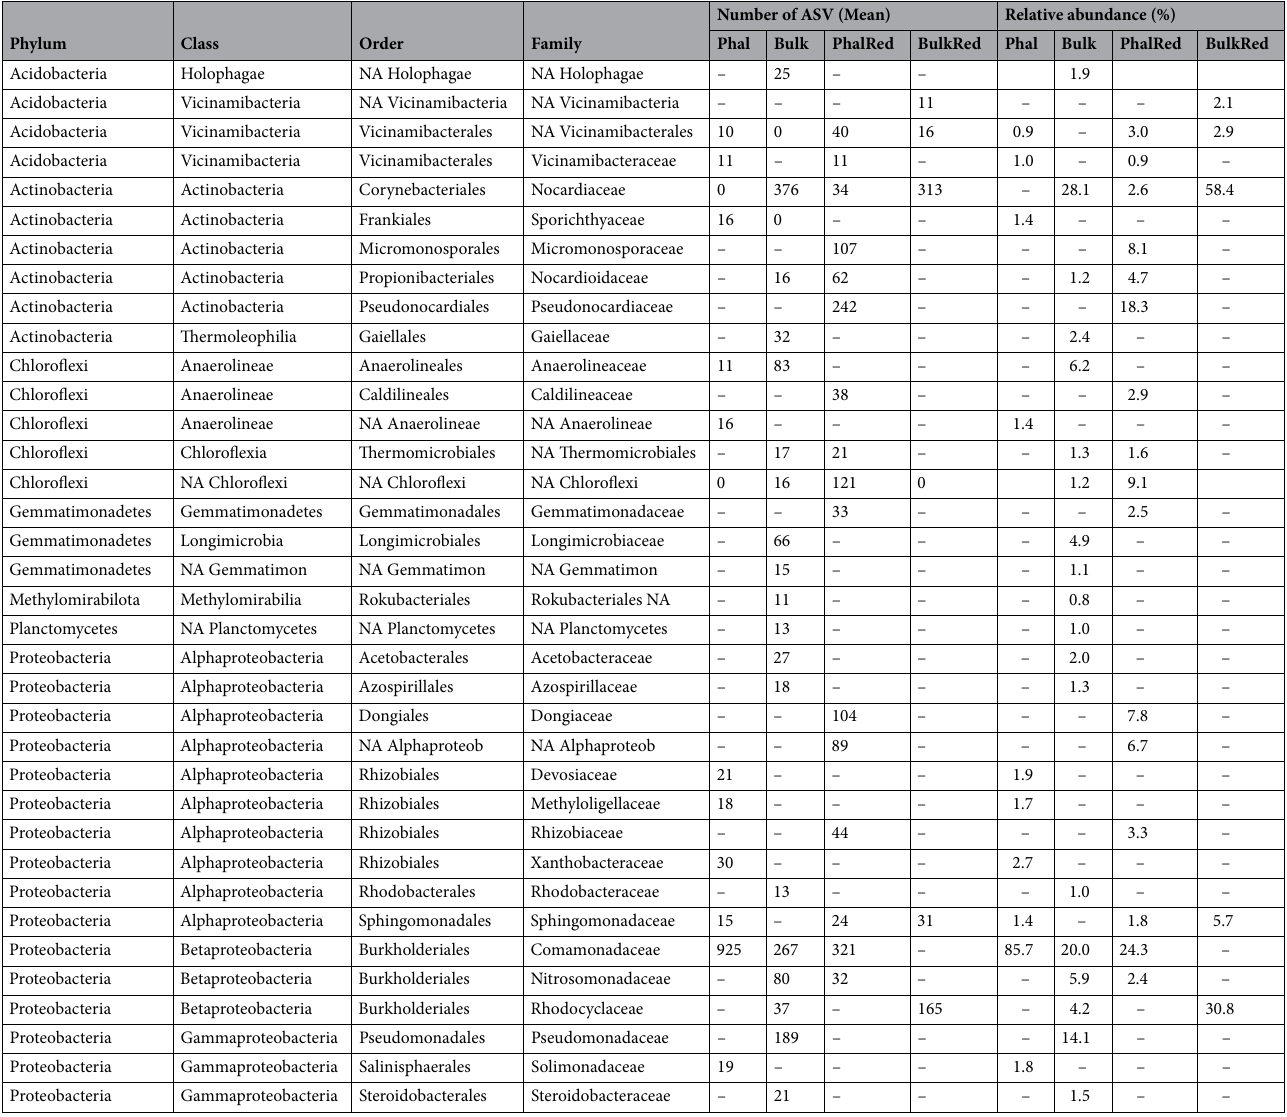
Table 1. Bacteria families incorporating 13 C derived from the mineralization of labeled 4-chlorobiphenyl identified after twenty-eight days (D 28 ) of SIP incubation. The table reports the mean number of ASVs retrieved for each bacteria family in the biological replicates of the four original soil treatments (Phal, Bulk, PhalRed and BulkRed) and the relative abundance over the 13 C-incorporating